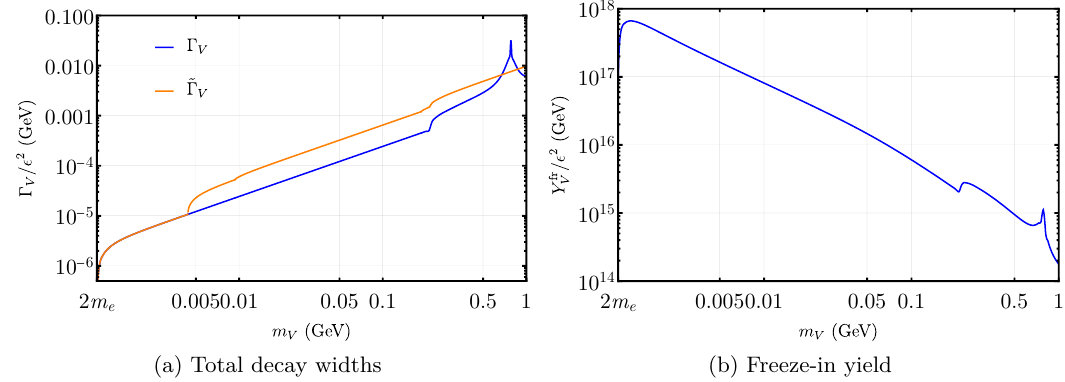
Figure 5 . Left panel: total decay width appearing in Eq. (5.3). Right panel: freeze-in yield using Eq.